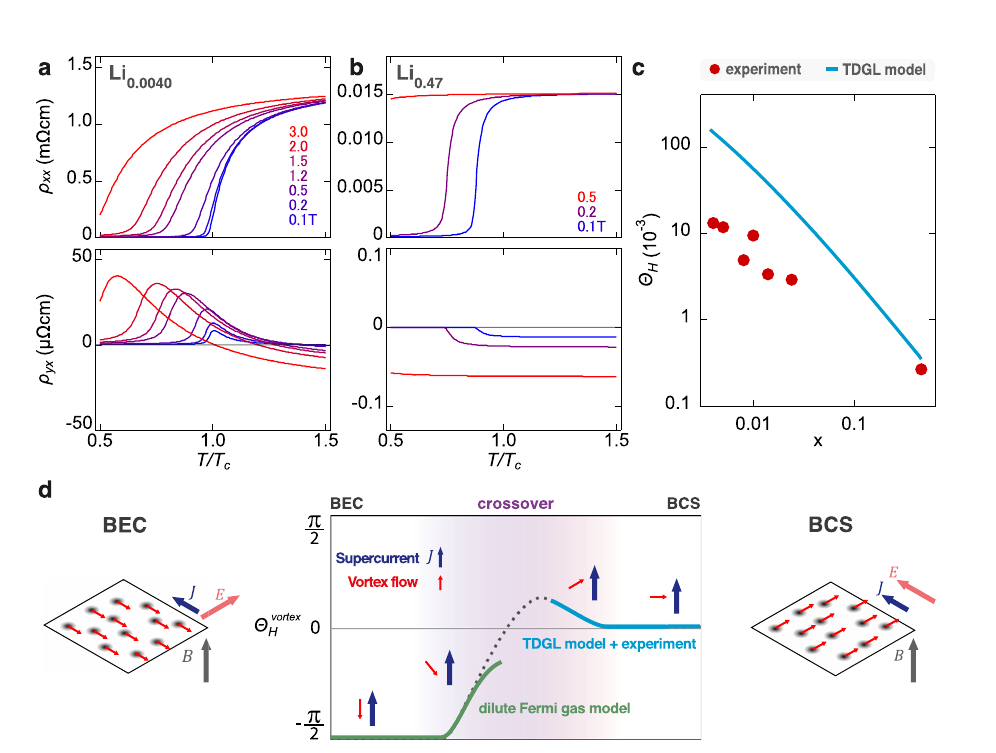
with decreased doping. At the highest doping ( x =0.47), the VHE is not visible anymore. Lines and markers show the T c ( B c2 ) superconductivity boundary deter- mined by the half resistance. Red circles mark the maximum R H values. b Doping dependence of Hall angle Θ H . With decreasing doping, Θ H is enhanced mono- tonically. In the high doping BCS regime, Θ H almost vanishes.